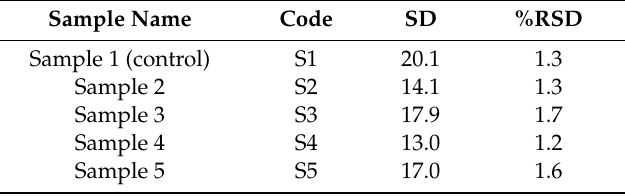
Figure 6. Pairs comparison of the different samples. Sample 1 (S1), sample 2 (S2), sample 3 (S3), sample 4 (S4) and sample 5 (S5). S1: Xylocaine ® , S2: Xylocaine ® + 0.338% CTE + 0.09% sodium saccharine, S3: Xylocaine ® + 0.184% CTE + 0.09% sodium saccharine, S4: Xylocaine ® + 0.414% RAS + 0.09% sodium saccharine, S5: Xylocaine ® + 0.237% RAS + 0.09% sodium saccharine. Table 2. Mean standard deviation (SD) and relative standard deviation (RSD) for each sample.